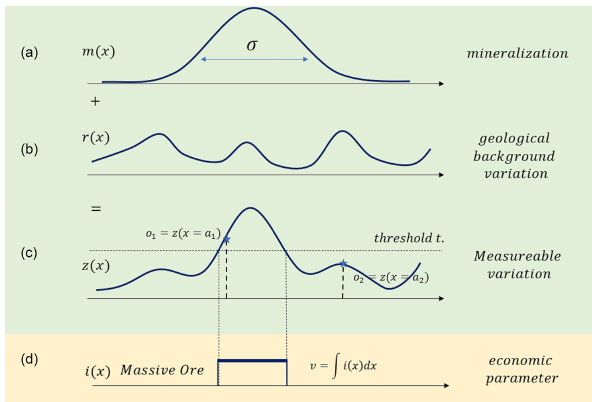
Figure 1. Example 1D mineralization. Panel (a) shows a mineral- ization that is altered by geological background variation (b) , re- sulting in the measurable variation (c) . The massive ore body (d) , whose volume is the economic parameter of interest, exists at loca- tions where z(x) exceeds a threshold